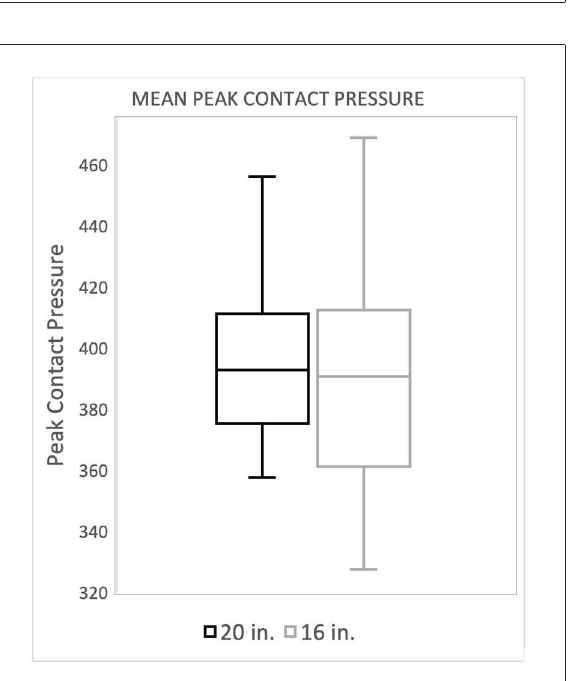
FIGURE5 Mean peak contact pressure when averaging the forelimbs. There was no significant difference between the standard (20 ′′ ) or preferred (16 ′′ ) height when averaging both peak contact pressure of both forelimbs.